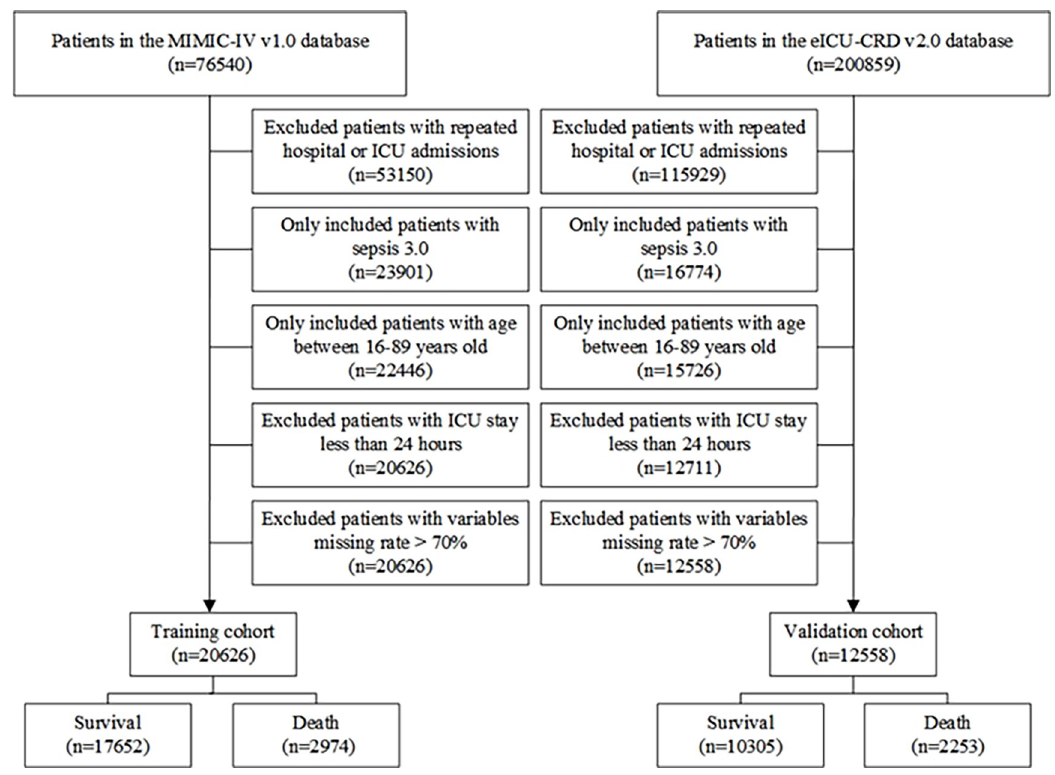
Fig 1. The flow chart of this